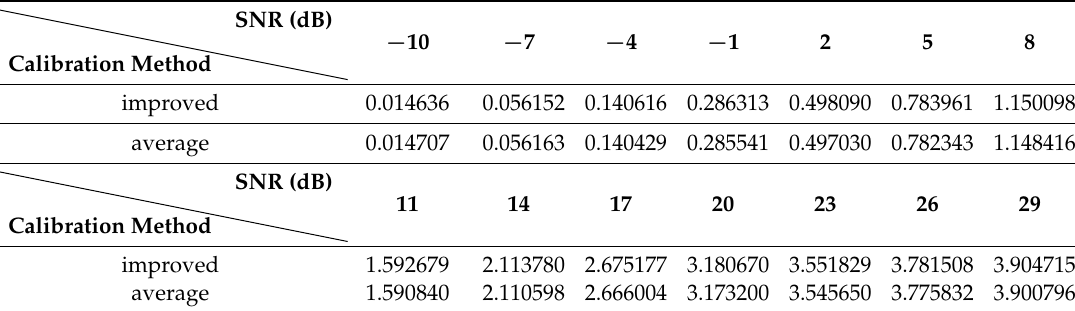
Table 2. System throughput comparison of the improved calibration method and the average calibration methods (Mbps). SNR—signal-to-noise ratio.